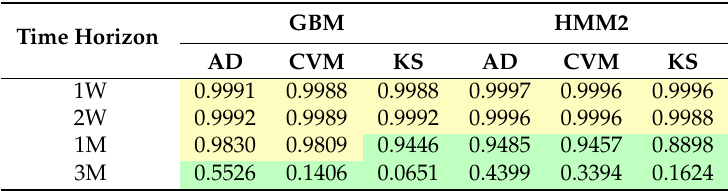
Table 3. Backtesting results for RUB/EUR with calibration window T c = 3 years, frequency of re-calibration δ c = 3 months, and backtesting window T b = 10